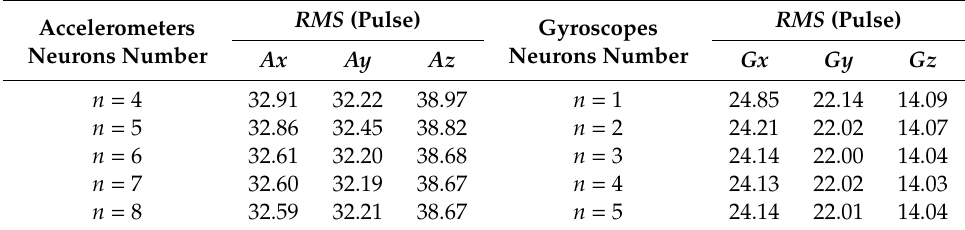
Table 7. The relationships between the model in method 3 and the RMS of calibration error.